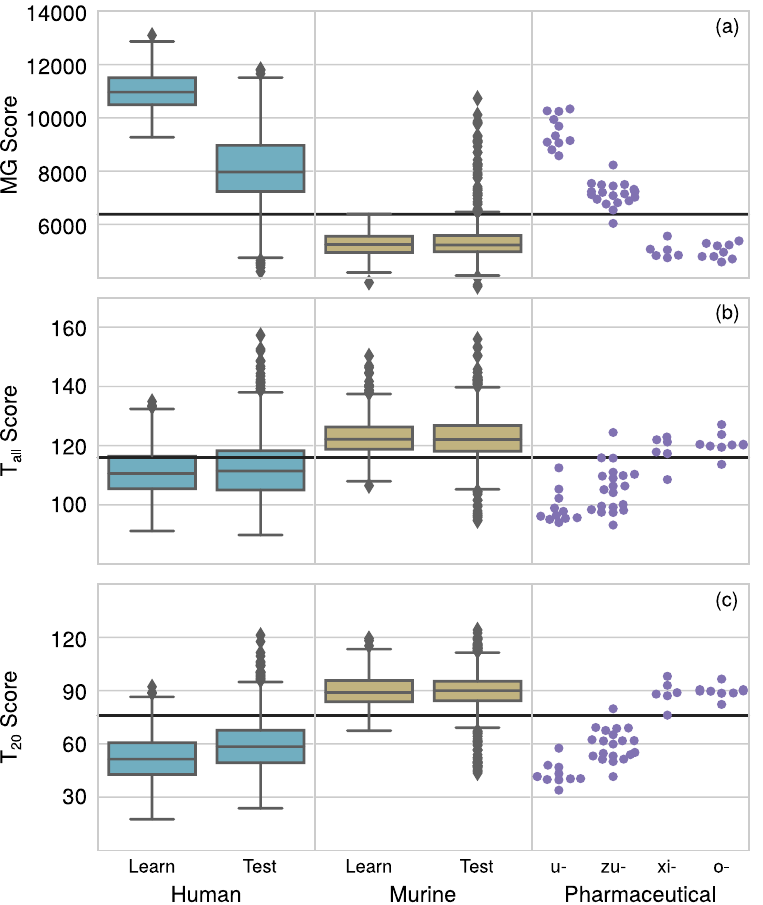
Figure 2. Boxplot of three score distributions for the different datasets: Panel (a): MG score; Panel (b): T all score; Panel (c): T 20 score. Pharmaceutical antibodies are indicated according to the suffix in their International Nonproprietary Name: “umab” are fully human antibodies; “zumab” are humanized antibodies, usually containing murine CDRs grafted on top of human framework variable regions; “ximab” are chimeric antibodies, obtained by assembling the whole murine variable region on top of a human constant part; “omab” are murine antibodies. Since we deal with just the antibodies’ variable regions, “ximab” and “omab” are indistinguishable. The horizontal lines signal the threshold score above (for the MG case) or below (for the other cases) which the sequence is classified as human. The threshold values are